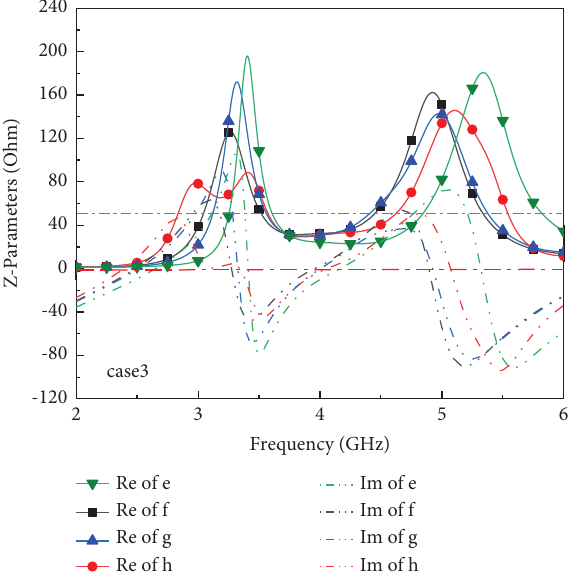
Figure 3: Z -parameters of cases